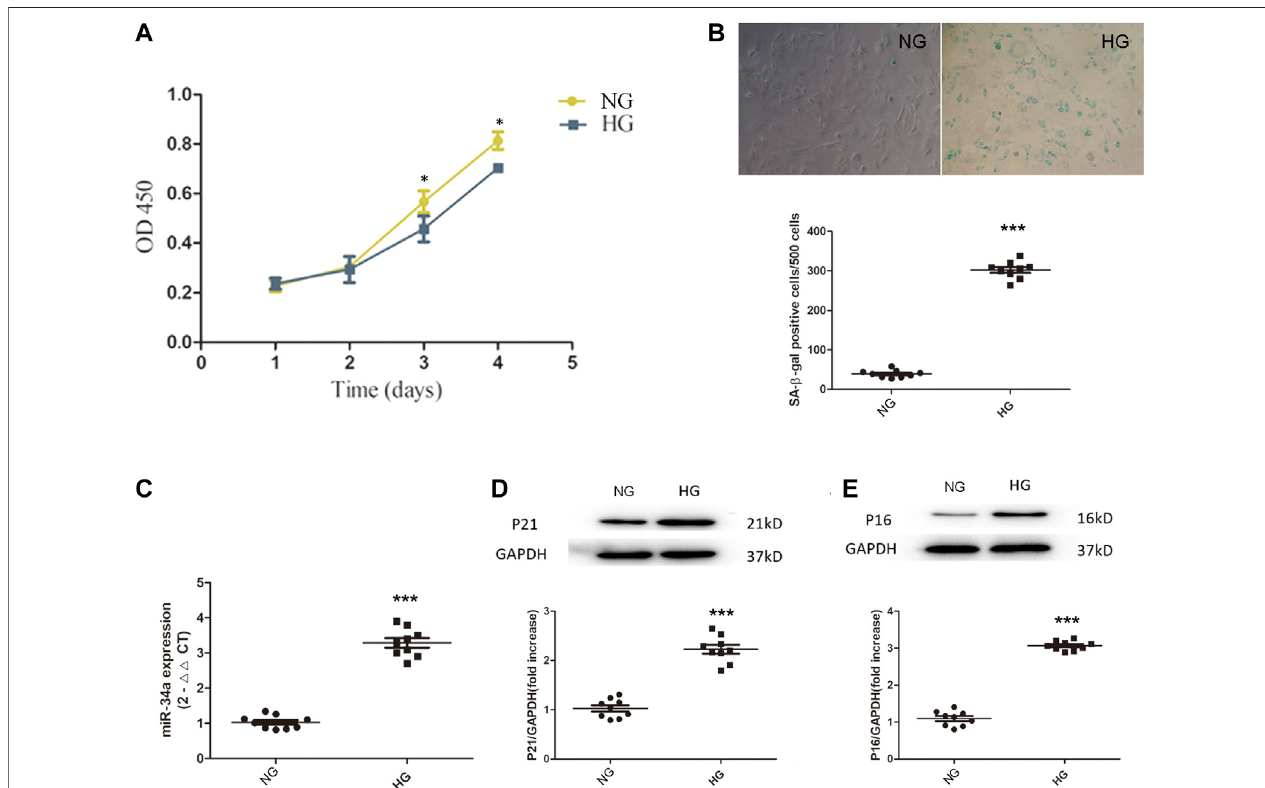
FIGURE1| HyperglycemiadamageBMSCs ’ cellfunction. (A) BMSCswereculturedinnormal-glucosemediumandhigh-glucosemedium.TheviabilityofBMSCs was detected by CCK8 assay. * p < 0.05. (B) SA- β -galactosidase staining experiment was used to detect the senescence level between NG group and HG group cells. *** p < 0.001. (C) theexpressionofmiR-34a wasdetermined byqRT-PCR.*** p < 0.001 (D,E) Westernblotanalysisshowedtheexpressionlevelsofsenescence-related proteins P21 and P16 in NG group and HG group. *** p <